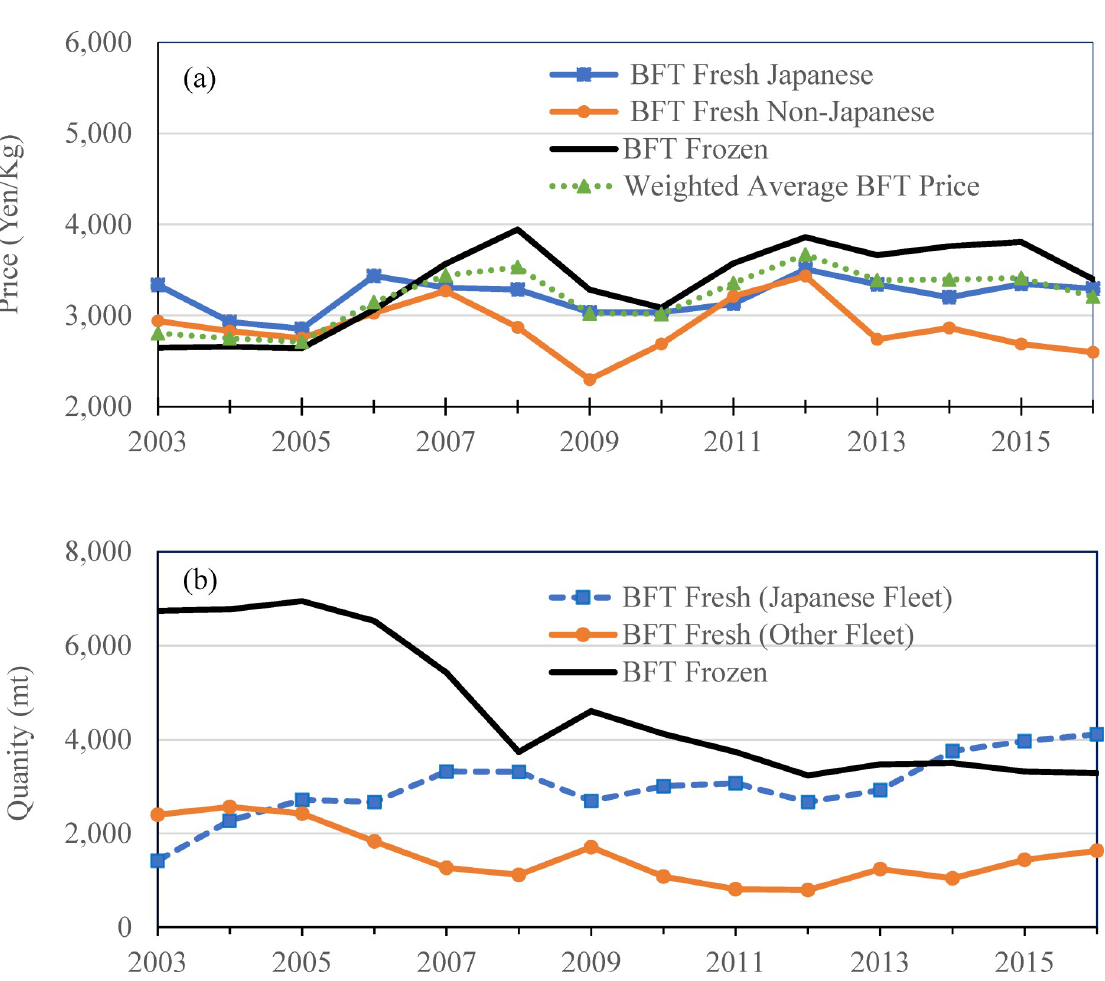
Fig 3. Annual auction market of bluefin tuna at Tokyo, Japan. (a) Monthly auction quantity weighted average price (Nominal price without inflation adjustment). (b) Auction quantity.